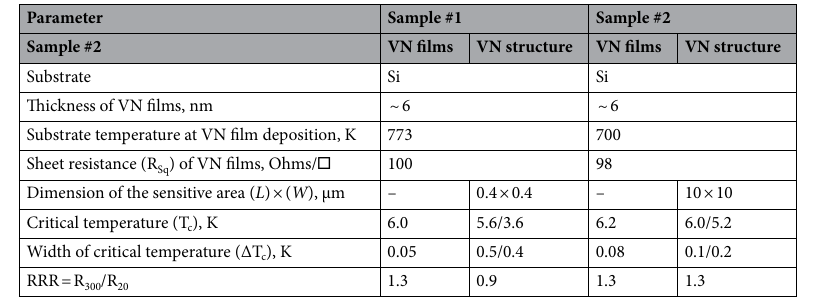
Table 1. Basic DC parameters of the initial VN films and VN